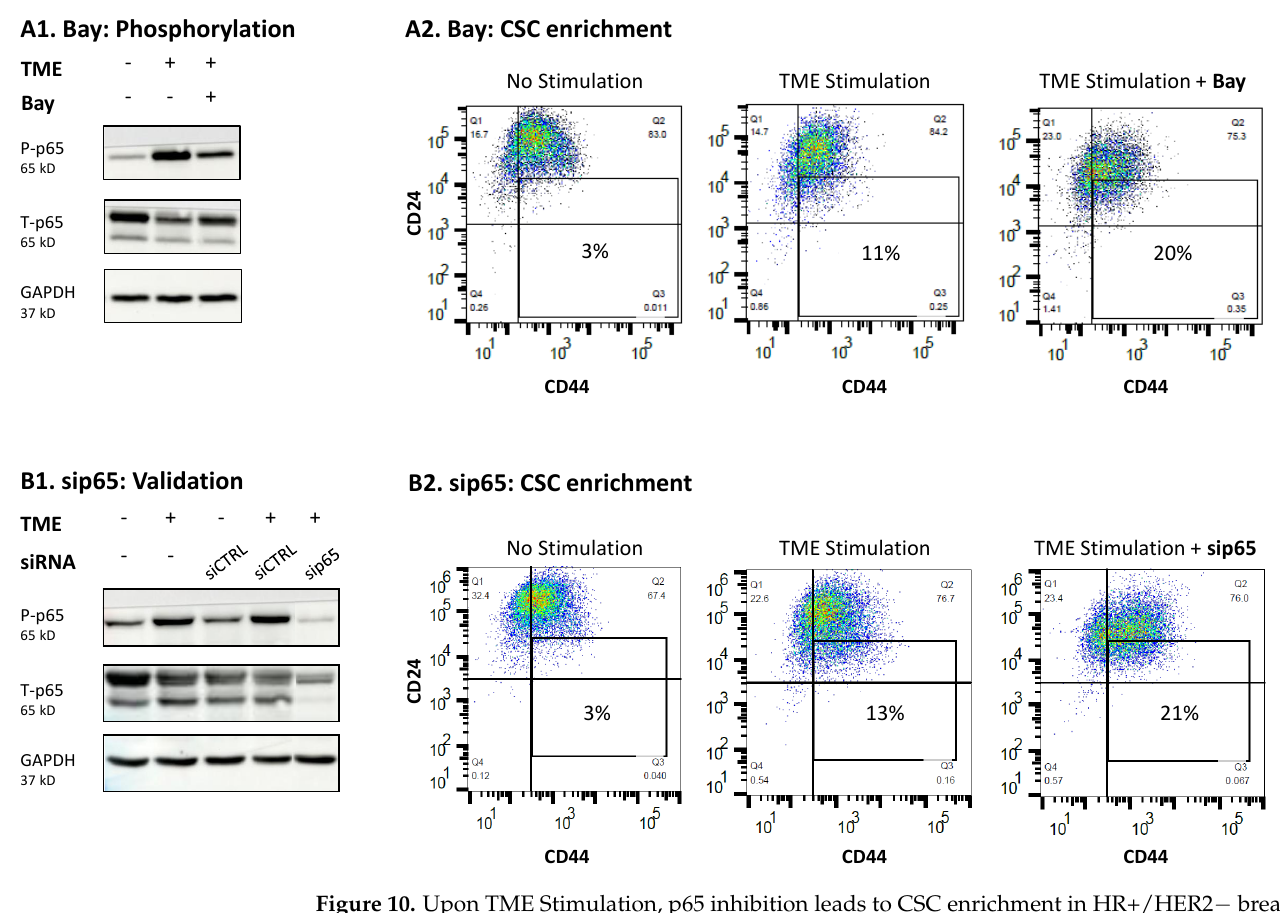
Figure 10. Upon TME Stimulation, p65 inhibition leads to CSC enrichment in HR+/HER2 − breast cancer cells: in MCF-7 cells, the effects of the p65 inhibitor Bay 11-7082 (Bay) and of p65 KD by sip65 on CSC enrichment were determined upon TME Stimulation (TME; concentrations as described in Figure 1) or treatment by a vehicle control (“No Stimulation”). ( A ) The cells were incubated